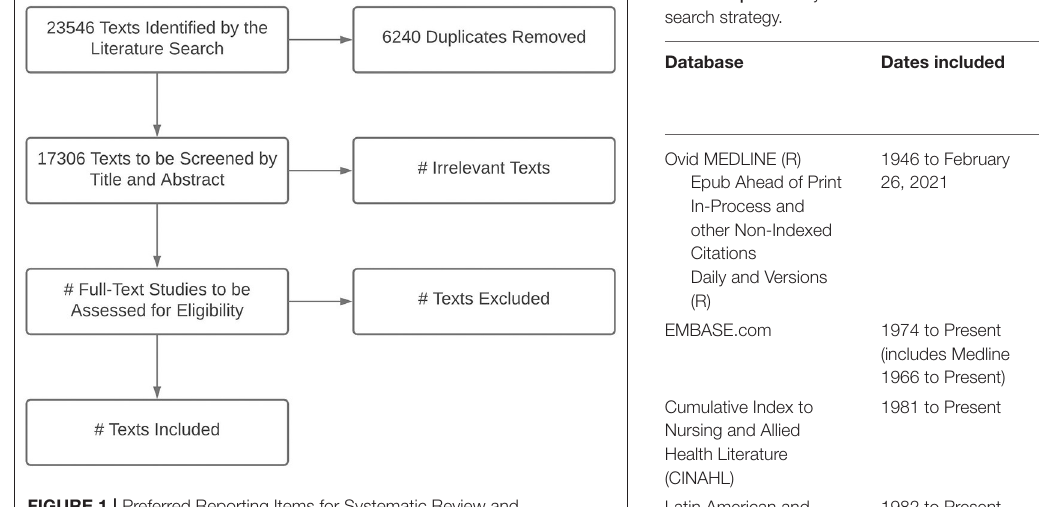
FIGURE 1 | Preferred Reporting Items for Systematic Review and Meta-Analysis Protocols (PRISMA) flowchart for title and abstract screening and text selection from the final search (conducted March 1, 2021).